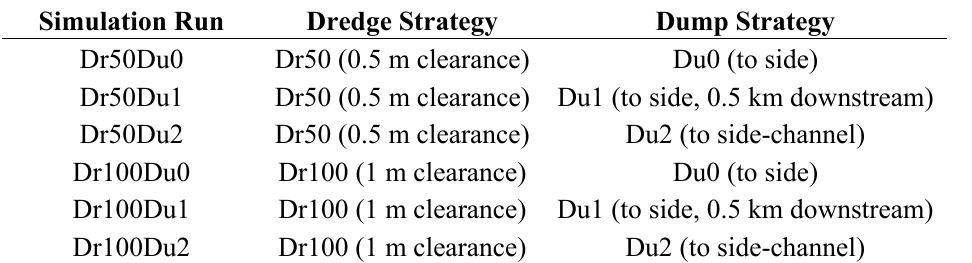
Table 1. Overview of dredge-and-dump